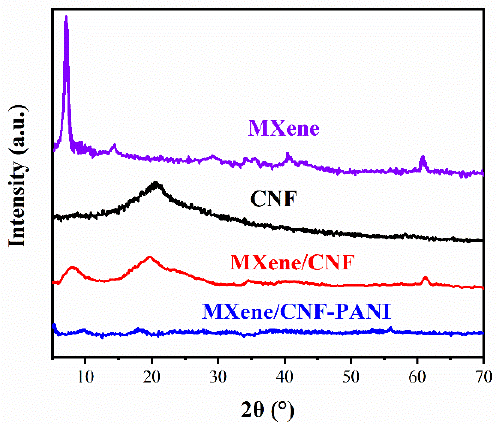
Figure 3. XRD patterns of CNFs, MXene, MXene/CNF aerogel films and MXene/CNF–PANI aerogel films.